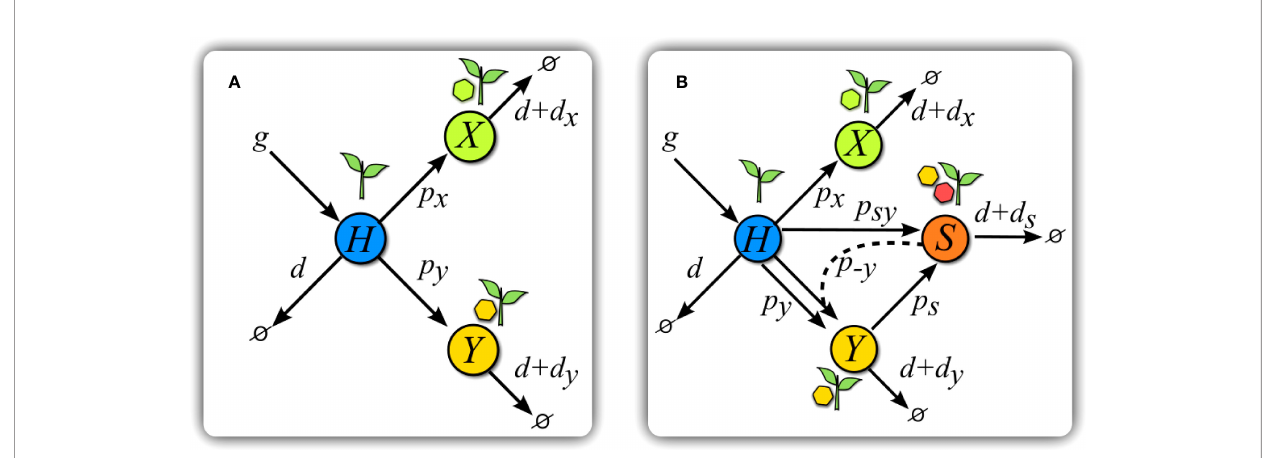
FIGURE 2 | Scheme of models. (A) Scheme of Model V. Healthy hosts H are seeded at a constant rate g and die with basal rate d . Transitions to infected states happen at rates p x and p y for each virus. Infected hosts X and Y suffer from an increase d i , $i= x, y$, in basal mortality. (B) Scheme of Model S. The introduction of a satellite with y as helper virus adds new transitions with respect to (A) . Hosts in class Y can get infected at a rate p s by a satellite upon contact with hosts in class S . Hosts in this latter class are simultaneously infected by virus y and its satellite, and have an increase d s in their mortality rate. Infection of H plants by the helper virus and the satellite simultaneously occurs at a rate p sy upon contact with class S . A co-infected plant S can also infect H plants only with virus y at a rate p − y . The color code is maintained all through the